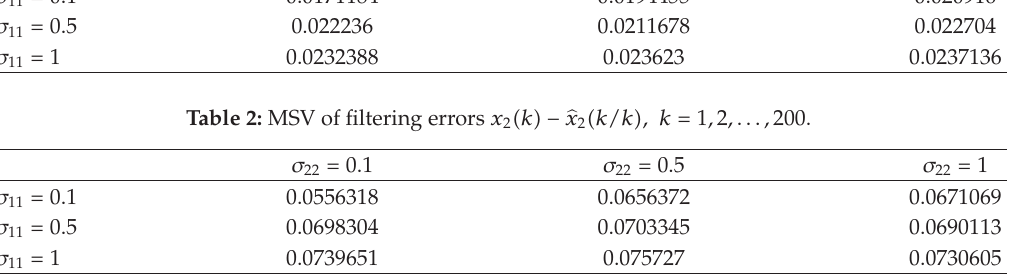
Table 1: MSV of filtering errors x 1 (cid:5) k (cid:6) − (cid:11) x 1 (cid:5) k/k (cid:6) , k (cid:7) 1 , 2 ,..., 200. σ 22 (cid:7) 0 . 1